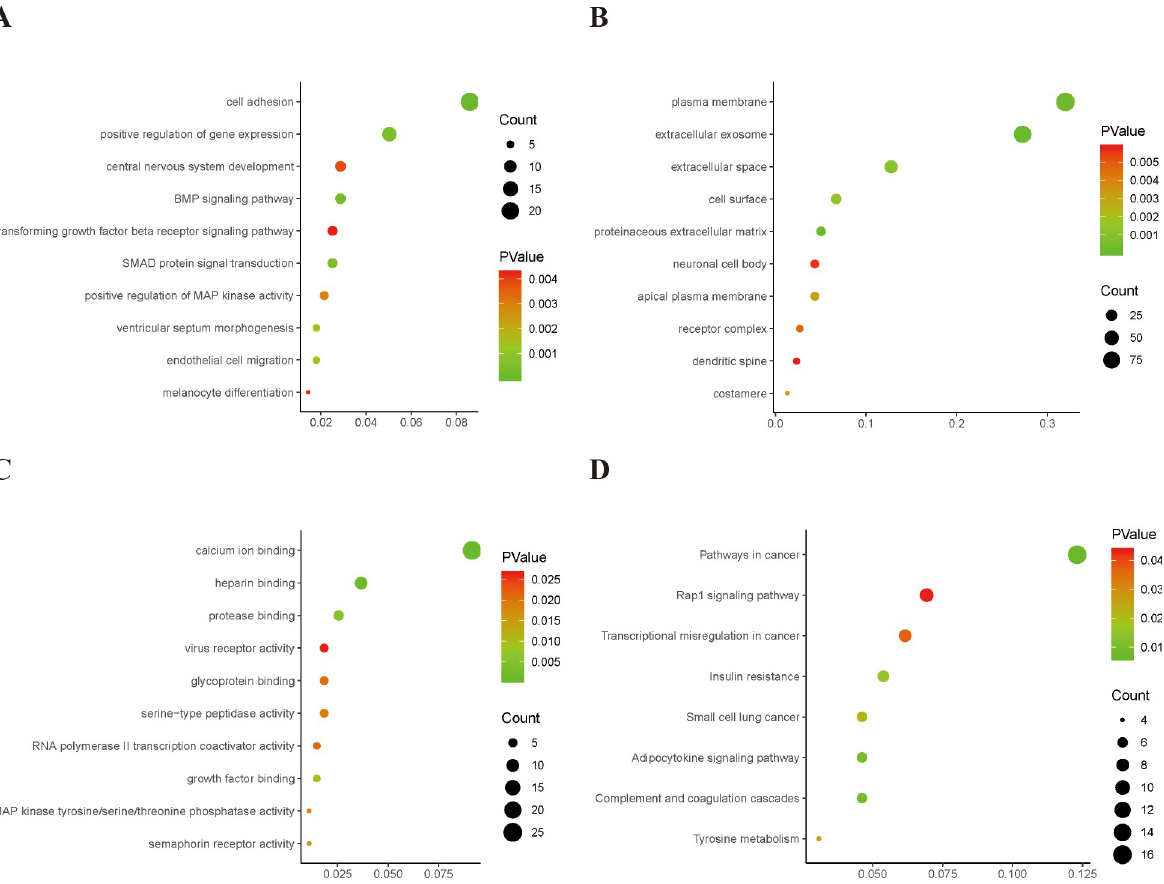
Fig 2. The top 10 gene ontology (GO) and significantly enriched KEGG pathways. A. BP; B. CC; C. MF; D. KEGG pathways. The X axis represents the enrichment levels; the Y axis represents the top 10 remarkably enriched categories. The color of the dot denotes the different P-value , and the size of the dot indicates the number of the candidate genes enriched in the GO and KEGG